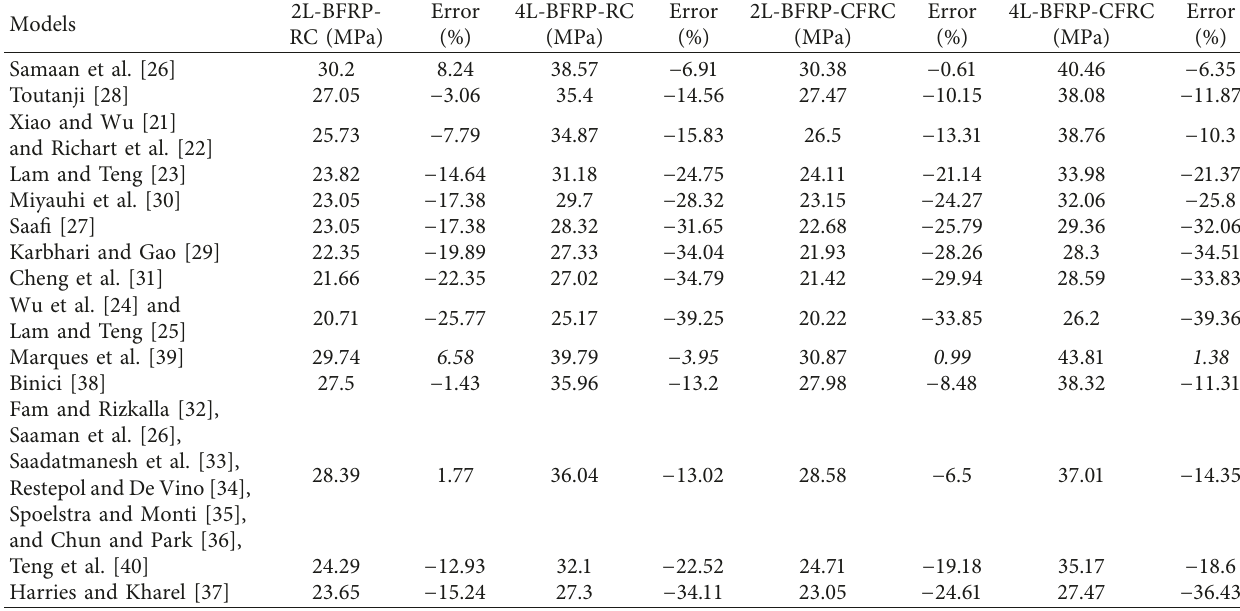
Table 5: Strength prediction of the small-size specimens by design-oriented confinement models.